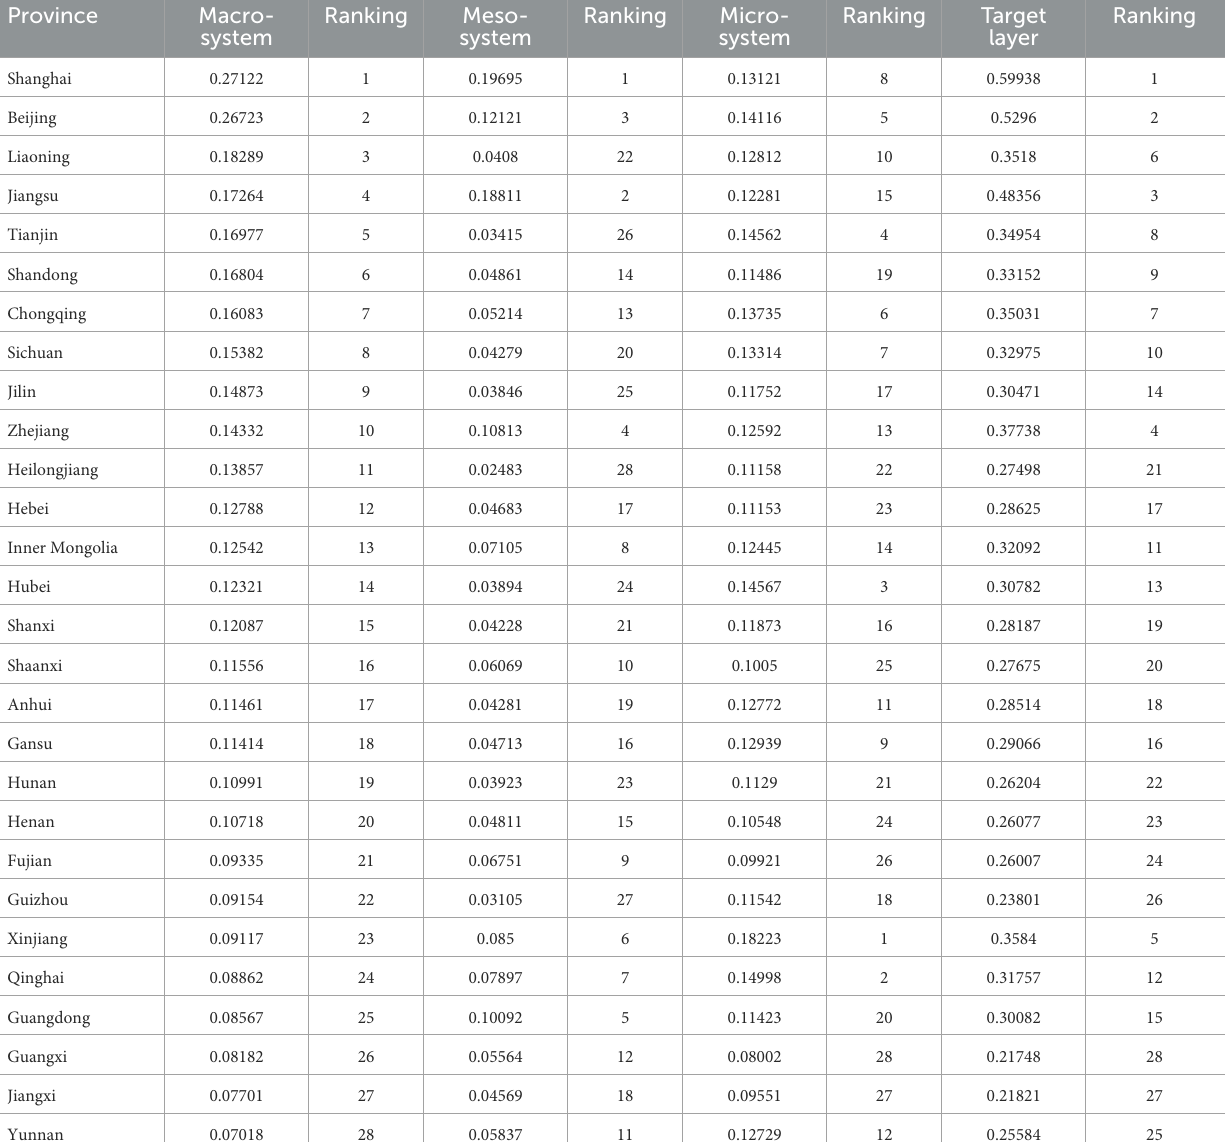
TABLE 7 Scores of system-layer measures of the degree of social disability risk for 28 provinces (municipalities and autonomous regions) in China in 2018. Province Macro- Ranking Meso- Ranking Micro- Ranking Target system system system layer